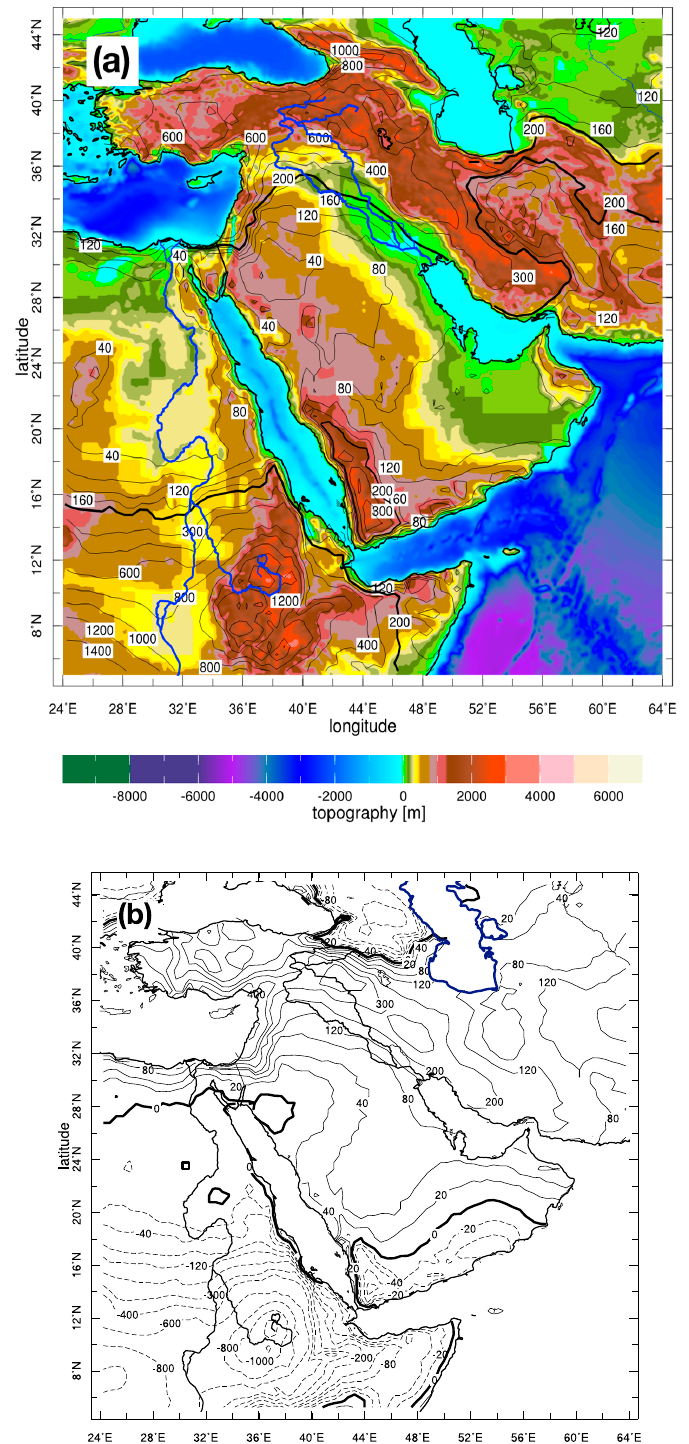
Figure 2. ( a ) The climatological annual rainfall in the eastern Mediterranean (contours) superimposed on the region’s topography (colors). Contours are in mm year − 1 drawn at uneven intervals to bring out the details in the rainfall poor areas. The isohyet of 200 mm year − 1 is highlighted to separate between the part of the region under arid climate and the relatively wet Mediterranean or monsoon climates. ( b ) The difference between cold (October–March) and warm (April–September) season rainfall, emphasizing the seasonal partition of precipitation throughout the region. The zero contours are highlighted by a bold line. Precipitation annual totals are calculated from the gridded, 0.5 ◦